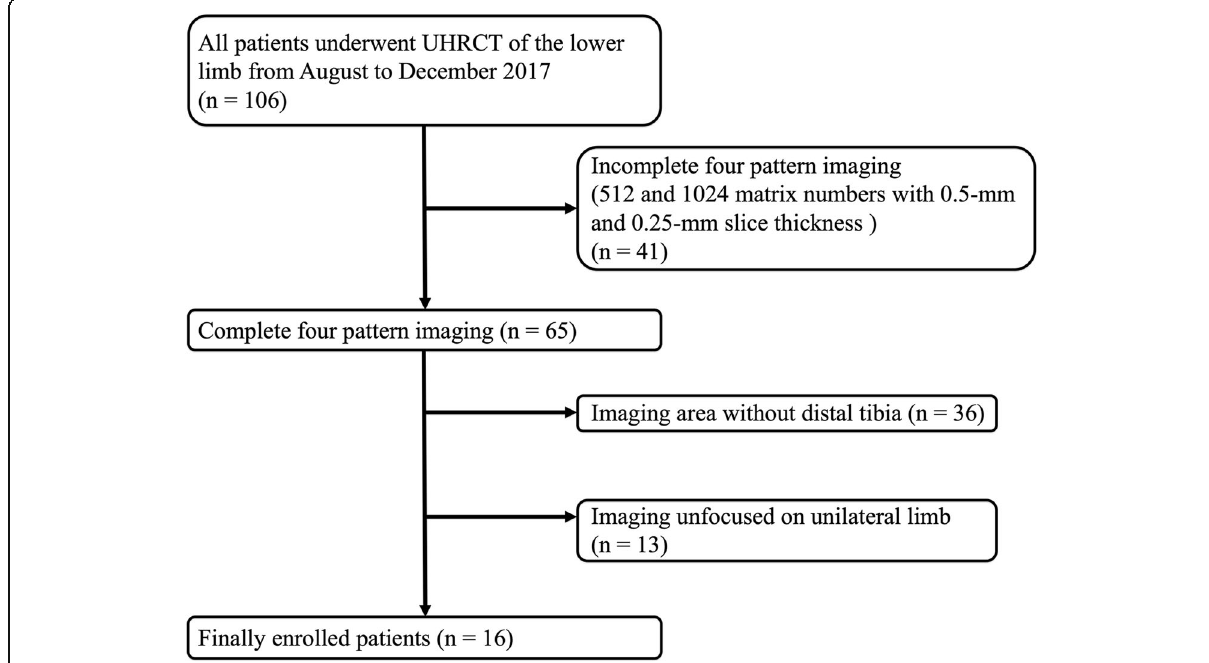
Fig. 2 Patient selection flowchart. UHRCT Ultra-high-resolution computed